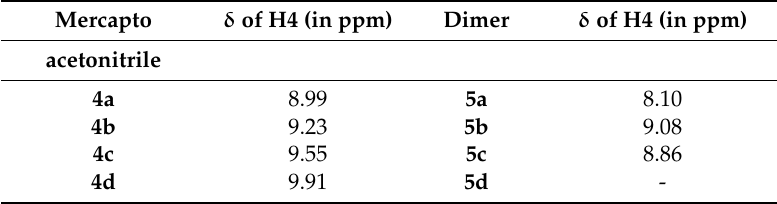
Table 3. 1 H-NMR data δ of H4 (in ppm) of the mercaptoacetonitriles ( 4a – 4d ) and the disulfur dimers ( 5a – 5c ).